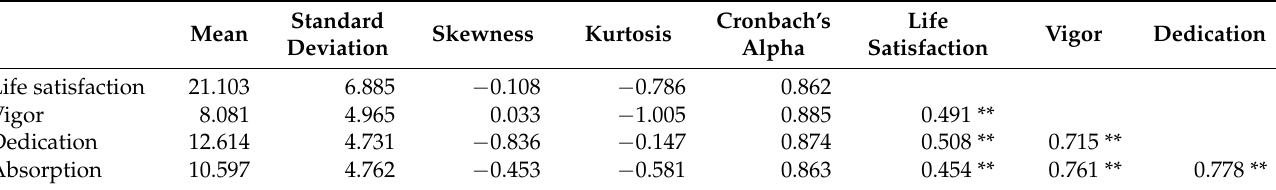
Table 4. Descriptive Analysis, Reliability, and Correlations between the Study Variables.